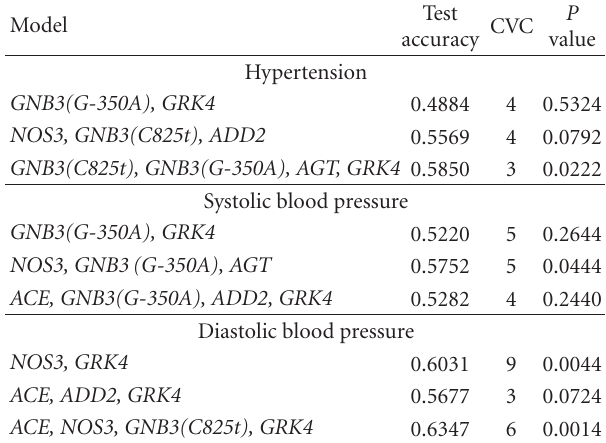
Table 7: Best predictive models from GMDR